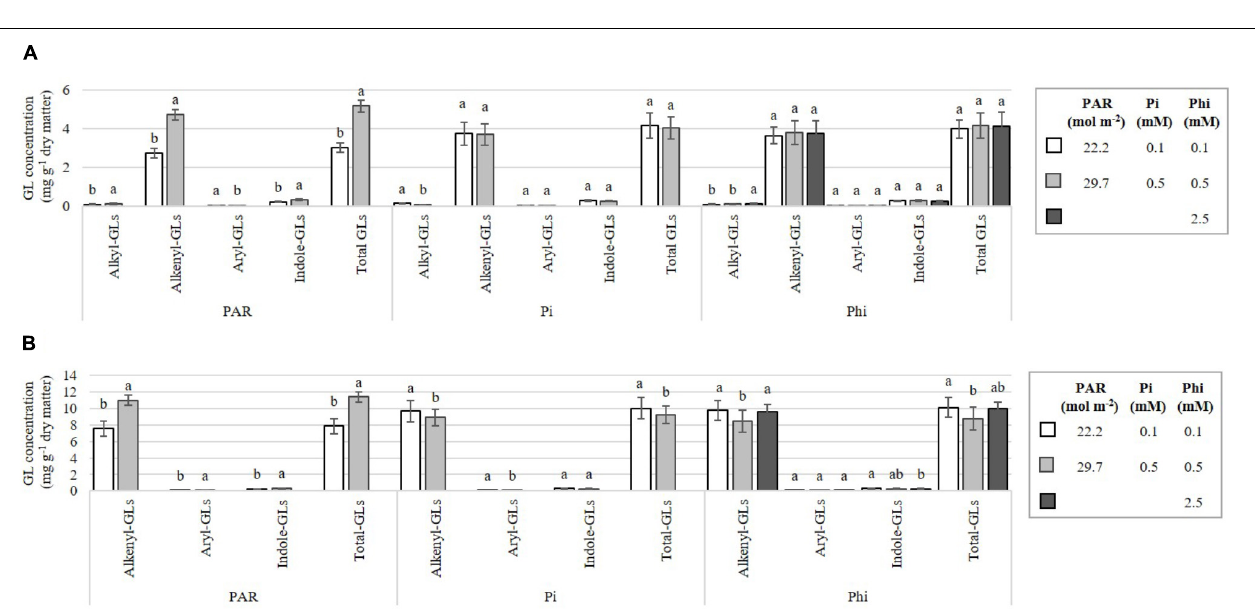
FIGURE 7 | Influence of mean daily photosynthetically active radiation (PAR), phosphate (Pi), and phosphite (Phi) on glucosinolate (GL) concentrations. Bars ± SD with different letters in each subfigure indicate significant differences at P ≤ 0.05 (Tukey’s test). (A) B. campestris cv. Mibuna Early. (B) B. juncea cv. Red Giant. 4MSB, 4-methylsulfinylbutyl-GL; 5MSP, 5-methylsulfinylpentyl-GL; 2OH-Butenyl, 2-hydroxybut-3-enyl-GL; Butenyl, but-3-enyl-GL; Propenyl, prop-2-enyl-GL; Pentenyl, pent-4-enyl-GL; 2PE, 2-phenylethyl-GL; 1MOI3M, 1-methoxyindol-3-ylmethyl-GL; 4MOI3M, 4-methoxyindol-3-ylmethyl-GL; I3M, indol-3-ylmethyl-GL;